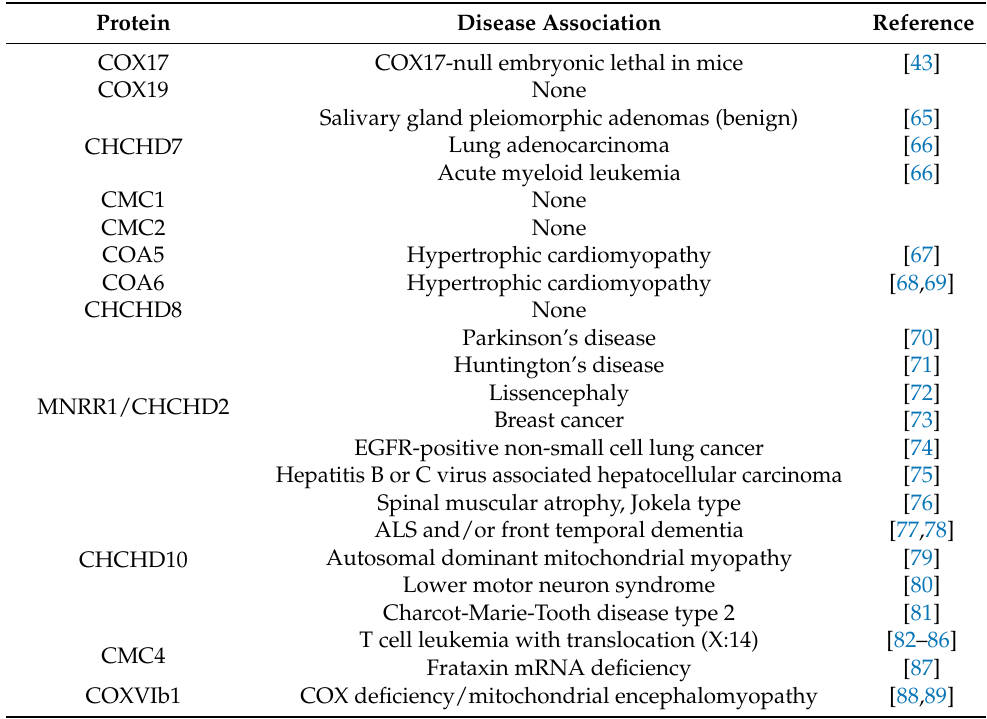
Table 3. COX-associated twin CX 9 C proteins and diseases.